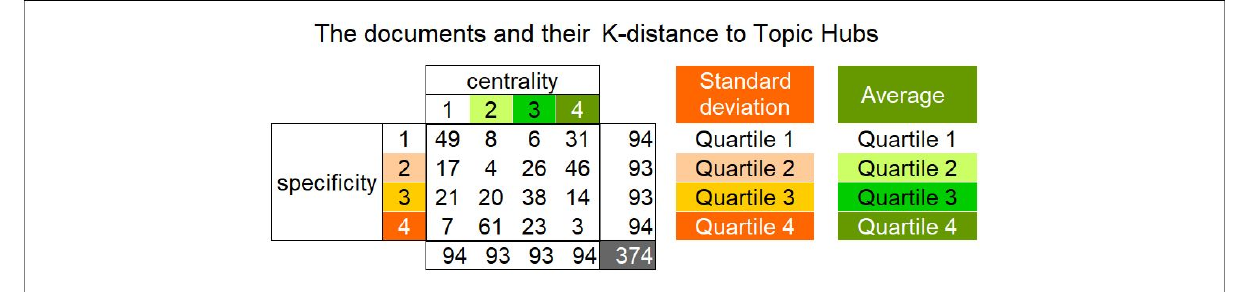
Figure 9. Classification of the documents in terms of centrality and specificity with respect to the nine topic hubs.